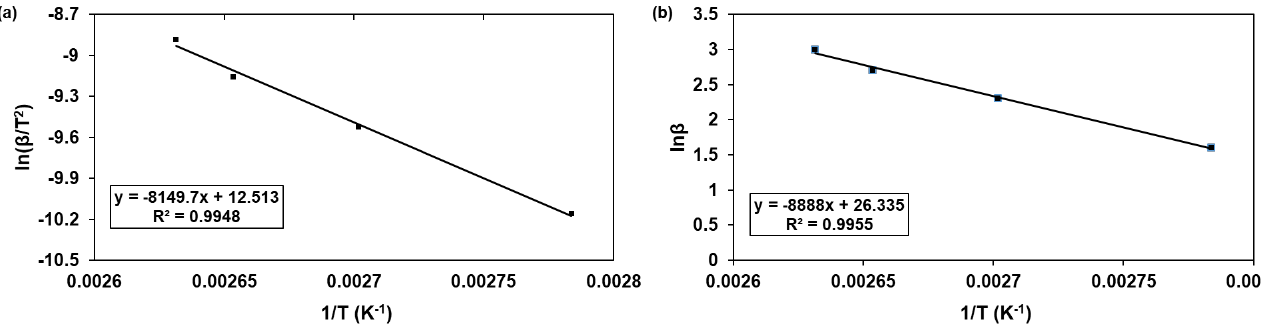
Figure 3. ( a ) Kissinger plot and ( b ) Ozawa plot of epoxy/thiol/MI system. Next, the reaction order ( n ) of the epoxy/thiol/MI curing was determined as 0.93 using the averaged E a value of 69.00 KJ/mol according to the simplified Crane equation (Equation (3)) [21]. Finally, the degree of curing ( α ) of the epoxy/thiol/MI system over time at various temperatures was obtained based on Equation (4) [21], and the results are shown in Figure 4. The curing degree of the epoxy/thiol/MI system increased